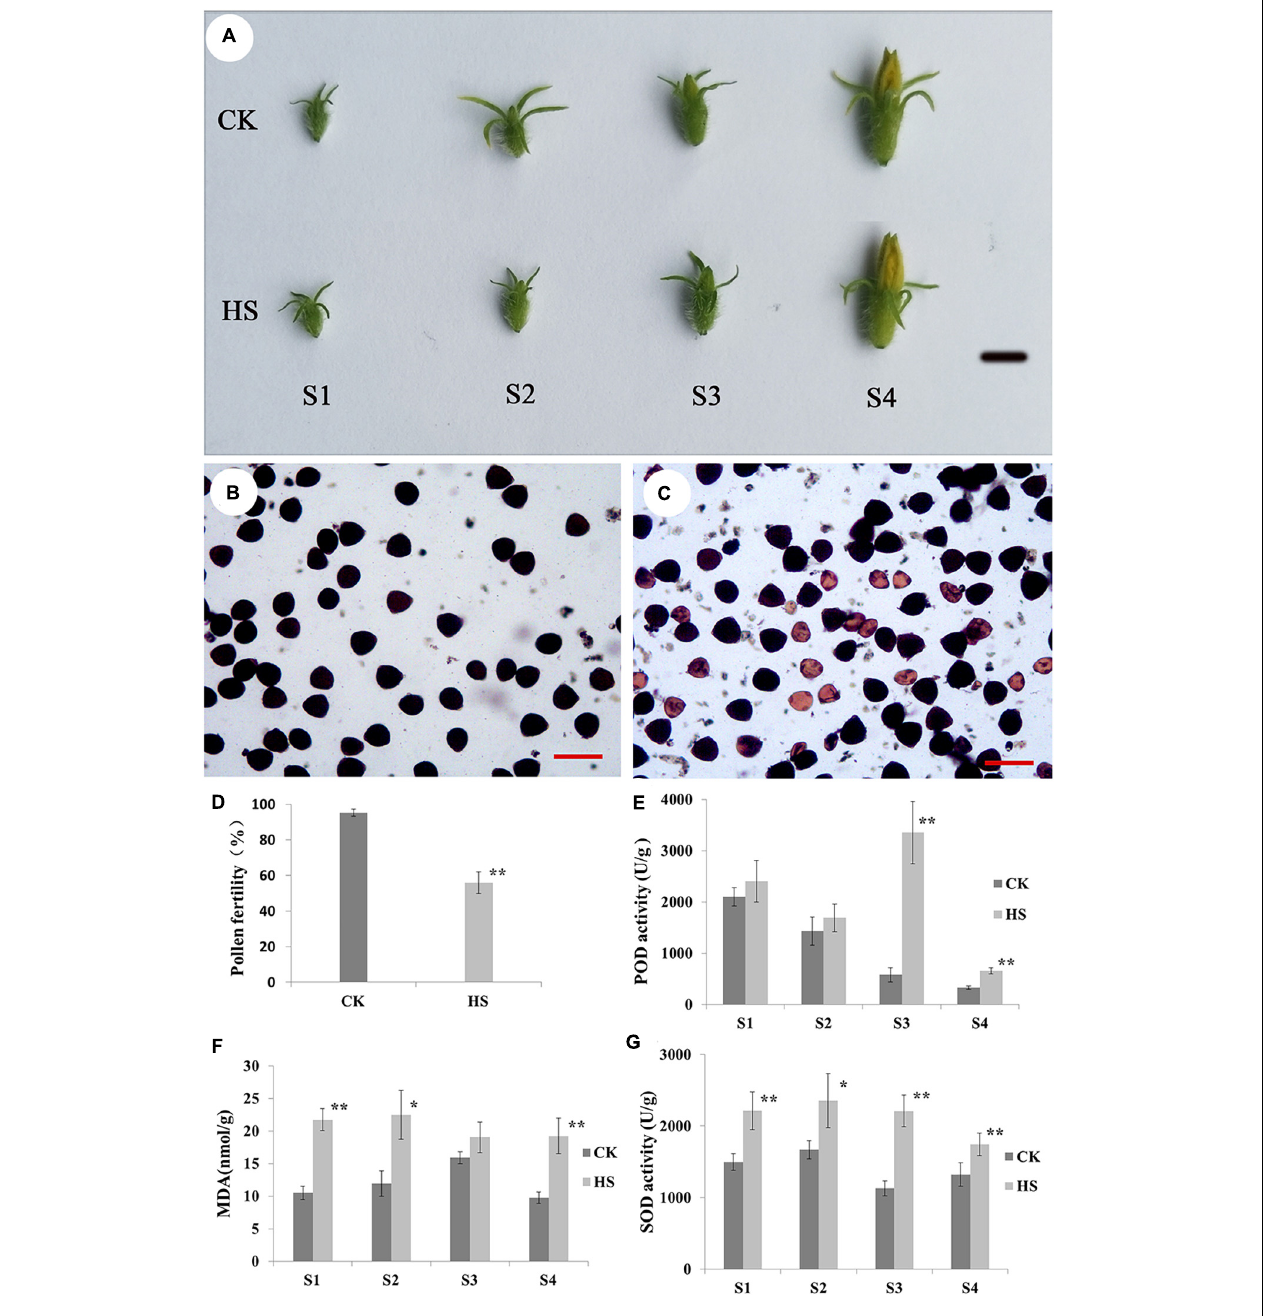
FIGURE 1 | Phenotype of male flower at different developmental stages between normal (CK) and heat stress (HS). (A) Phenotype of male flower at different developmental stages between CK and HS, bar = 1cm. Pollen grain of CK (B) and HS (C) observed by staining with 1% iodine-potassium (I 2 -KI), pollen fertility (D) , bar = 100 µ m. Peroxidase (POD) (E) , malondialdehyde (MDA) (F) , and superoxide dismutase (SOD) (G) in anther of CK and HS at male flower development stages.